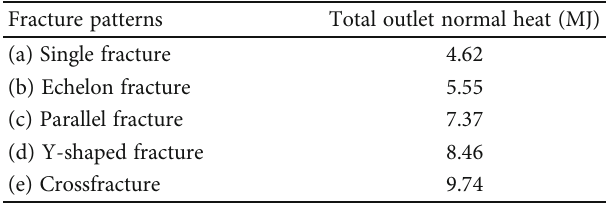
Figure 9: Total normal heat fl ux at the outlet of fractured rocks with fi ve di ff erent patterns. Table 2: Total outlet normal heat of di ff erent types of fractures. Fracture patterns